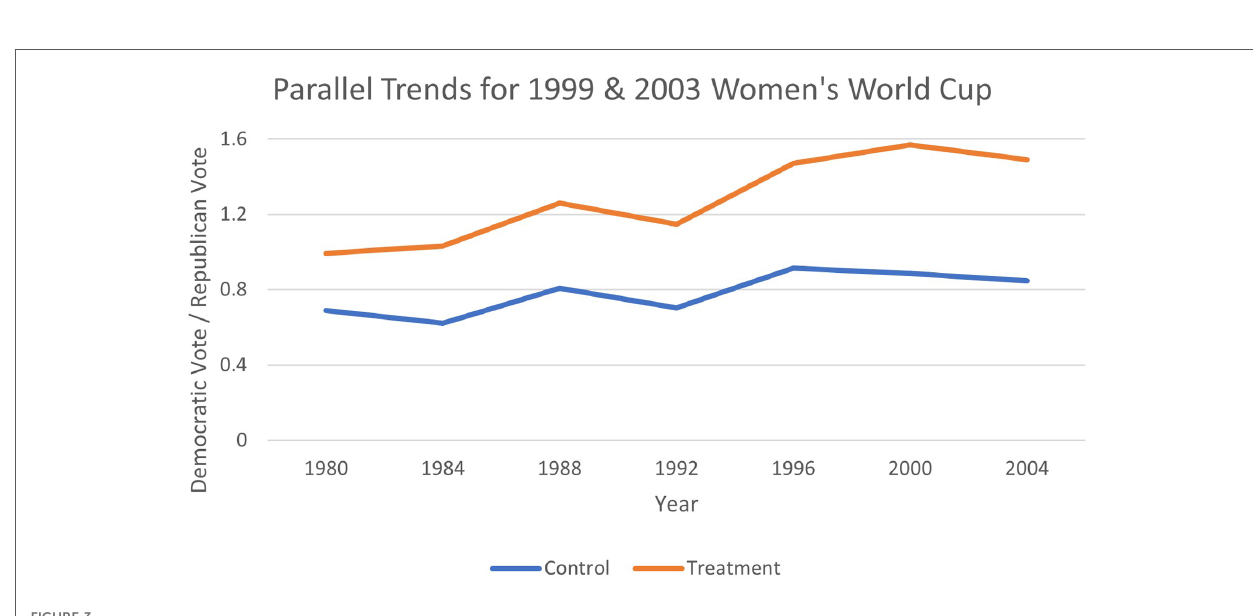
FIGURE 3 Testing parallel trends for 1999 and 2003 Women ’ s World Cup.